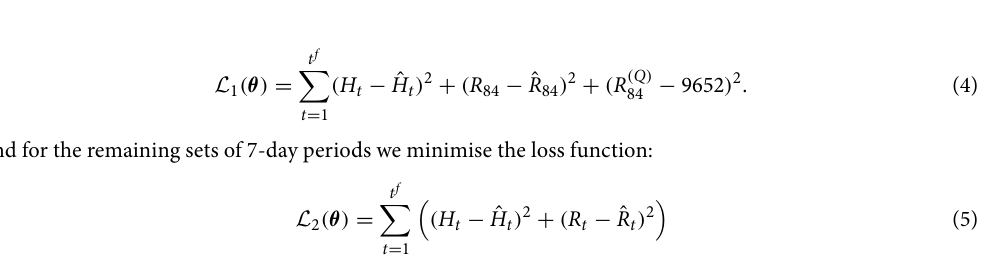
Figure 7. Observed and calibrate course of compartments H, R and D, and flows coming into compartment